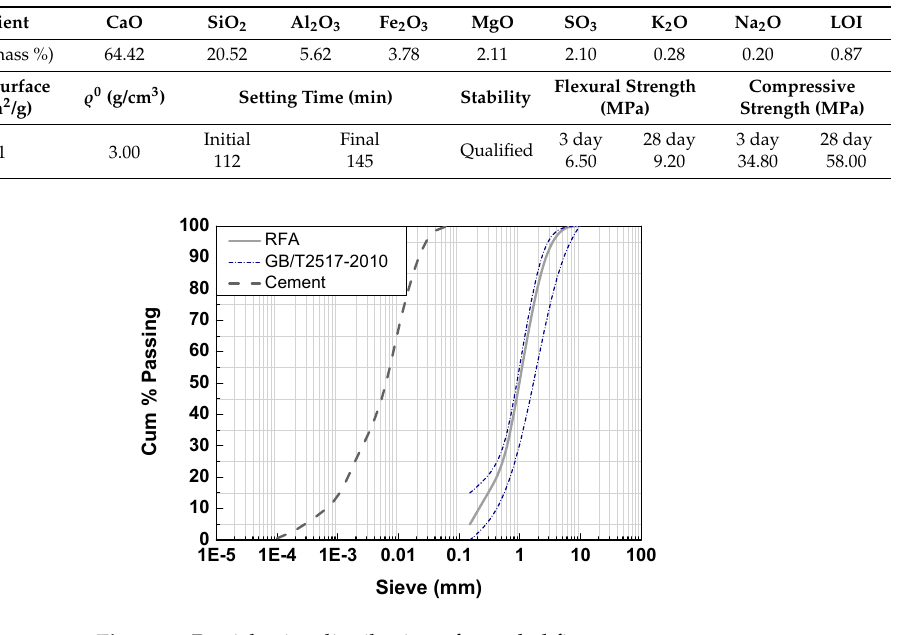
Table 1. Chemical compositions and physical properties of cement.